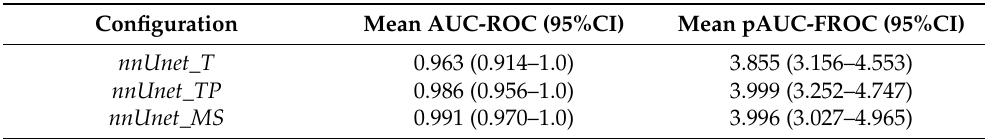
Table 2. Mean and 95% confidence interval (95% CI) of the area under the ROC curve (AUC-ROC) and partial area under the FROC curve (pAUC-FROC) for the internal five-fold cross-validation for each